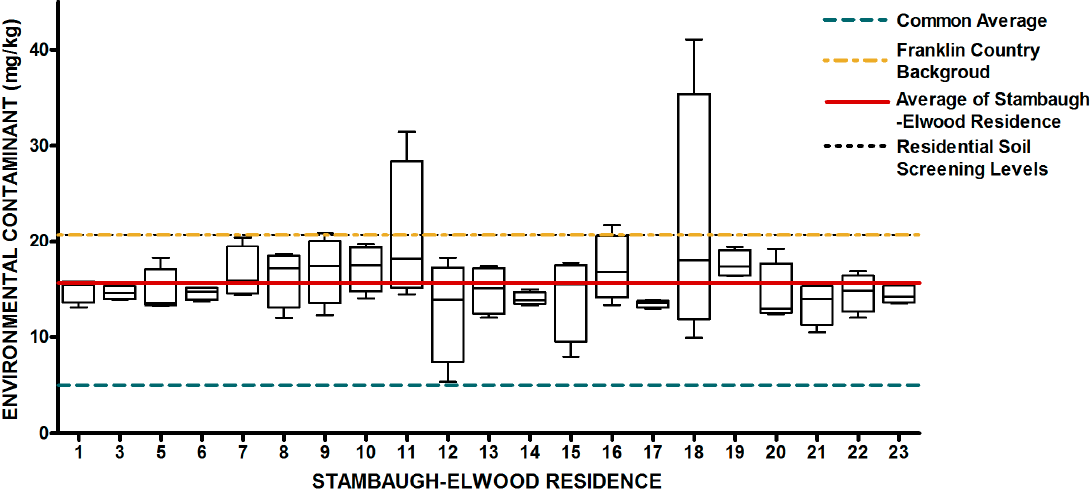
Figure 7. Residential urban soil level of As in the Stambaugh-Elwood community versus Franklin County (background), common averages and residential screening levels (RSLs) (mg/kg soil). Soil samples were taken from 21 of 46 residences that consented for the study in compliance with OSU IRB Protocol 2014B0445-exempt. Each sample consisted of four subsamples. Analysis proceeded following EPA Method 3051A, and digests were subsequently analyzed for metals using an Agilent 700